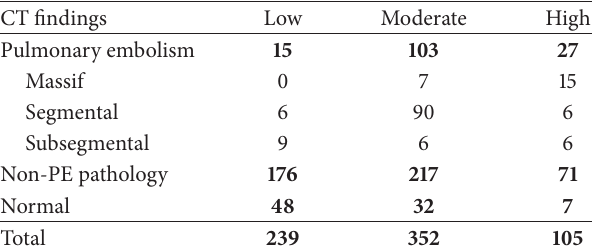
Table 3: CT findings—Wells score.